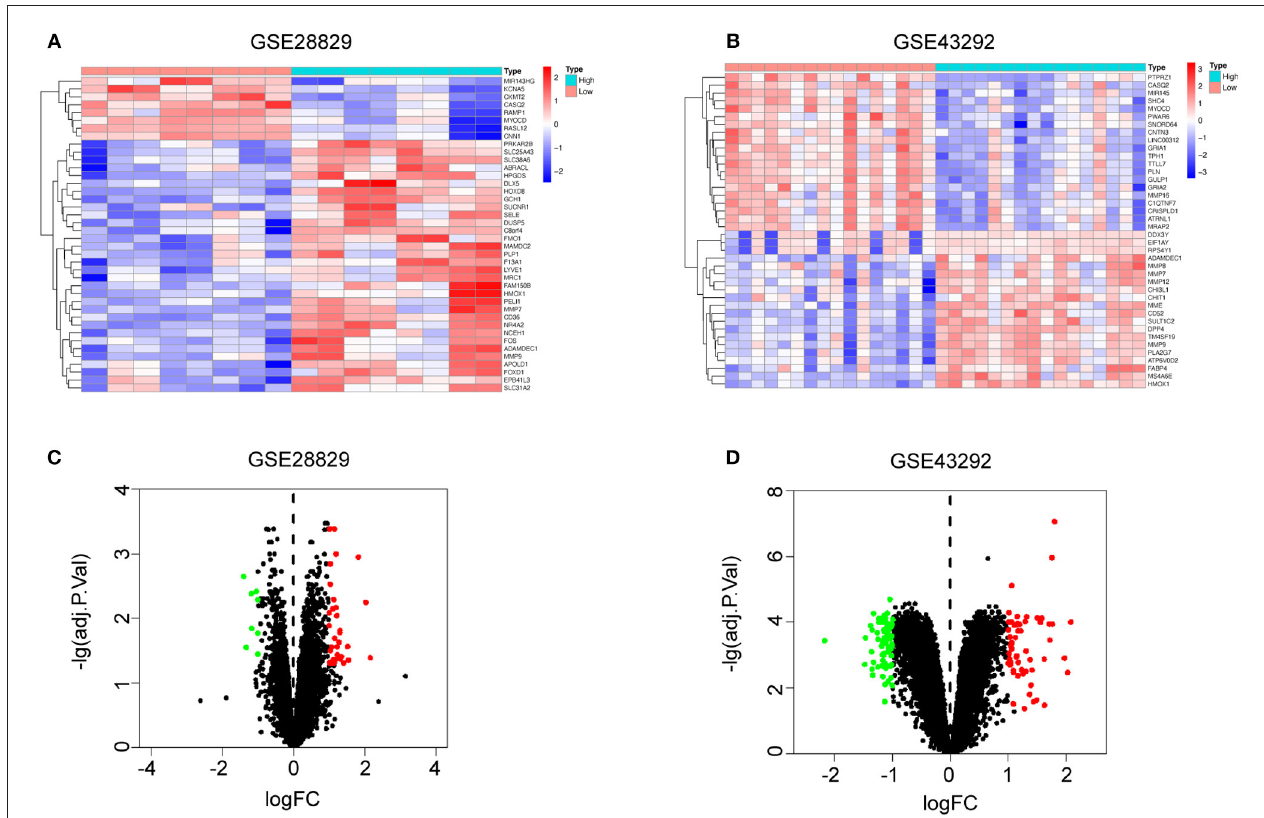
FIGURE 5 | Single-gene analysis of HMOX1 in atherosclerotic plaques. Heatmaps showing DEGs in HMOX1 high-expression group compared to HMOX1 low-expression group in GSE28829 (A) and GSE43292 (B) . Volcano plots of DEGs in HMOX1 high-expression group compared to HMOX1 low-expression group in GSE28829 (C) and GSE43292 (D)